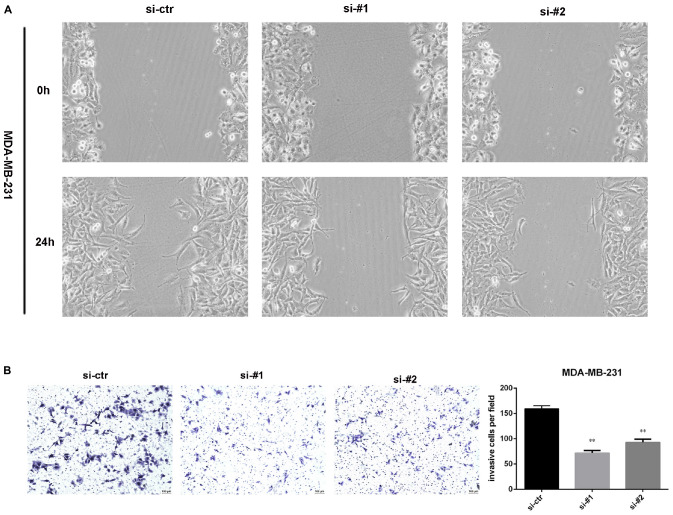
AFAP1-AS1 knockdown inhibited cell invasion and migration. (A) Wound-healing assay was used to measure cell migration. These pictures show that cell migration of TNBC cells was significantly inhibited in AFAP1-AS1 knockdown groups. (B) Transwell invasion assay was used to measure cell invasion of MDA-MB-231 cells transfected with siRNA-ctr, siRNA#1, or siRNA#2 (∗∗P < 0.01). The representative data from three independent experiments are shown.